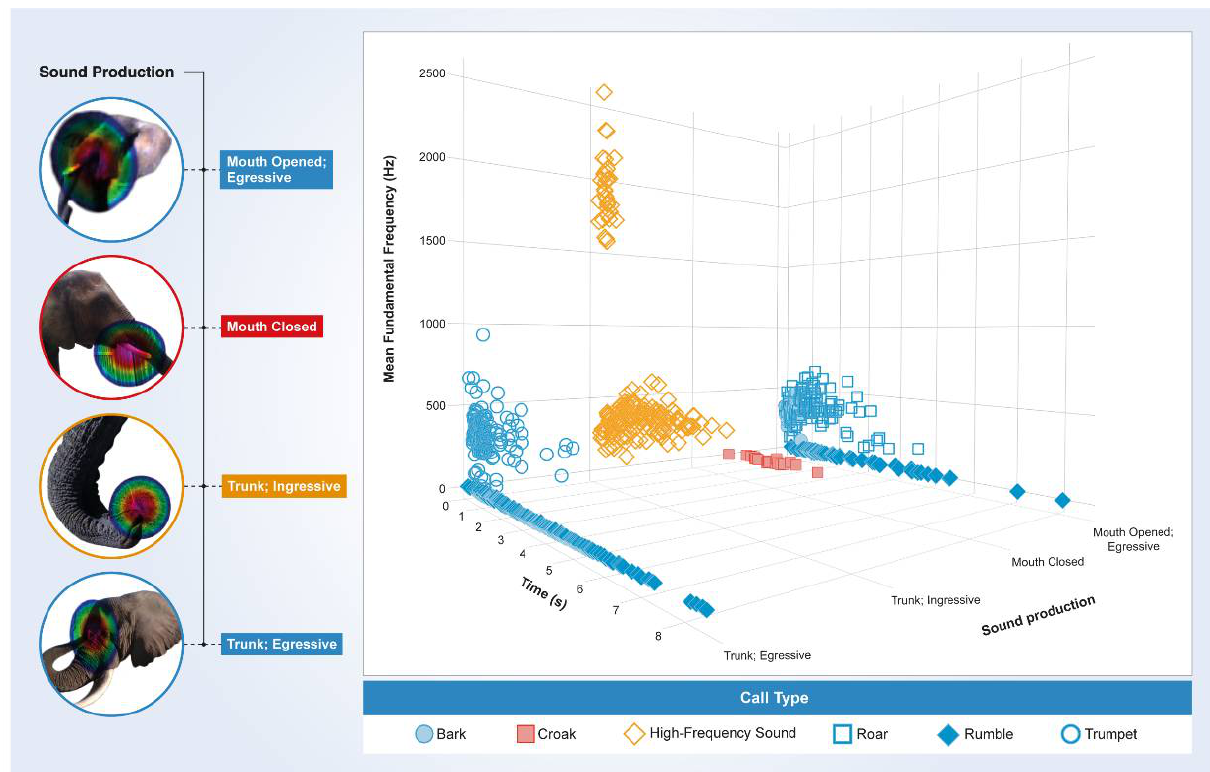
Figure 3. Comparison of periodic vocalizations. Three-dimensional scatter plot (duration, F0 and sound production) showing 625 vocalizations with measurable F0 of adult, adolescent and calf African savanna elephants (blue icons), in comparison with the idiosyncratic croak and the novel HFS. Morula’s and Jabu’s HFSs are considerably lower (all HFSs below 1000 Hz) than Sawu’s (all HFSs above 1500 Hz). These sounds, particularly the HFSs from Sawu, are special because the highest-pitched calls documented in adult African elephants are trumpets and roars reaching mean fundamental frequencies of around 500 Hz maximum. Supplementary Figure S1 gives an interactive version of this scatter plot to view the data from different angles and